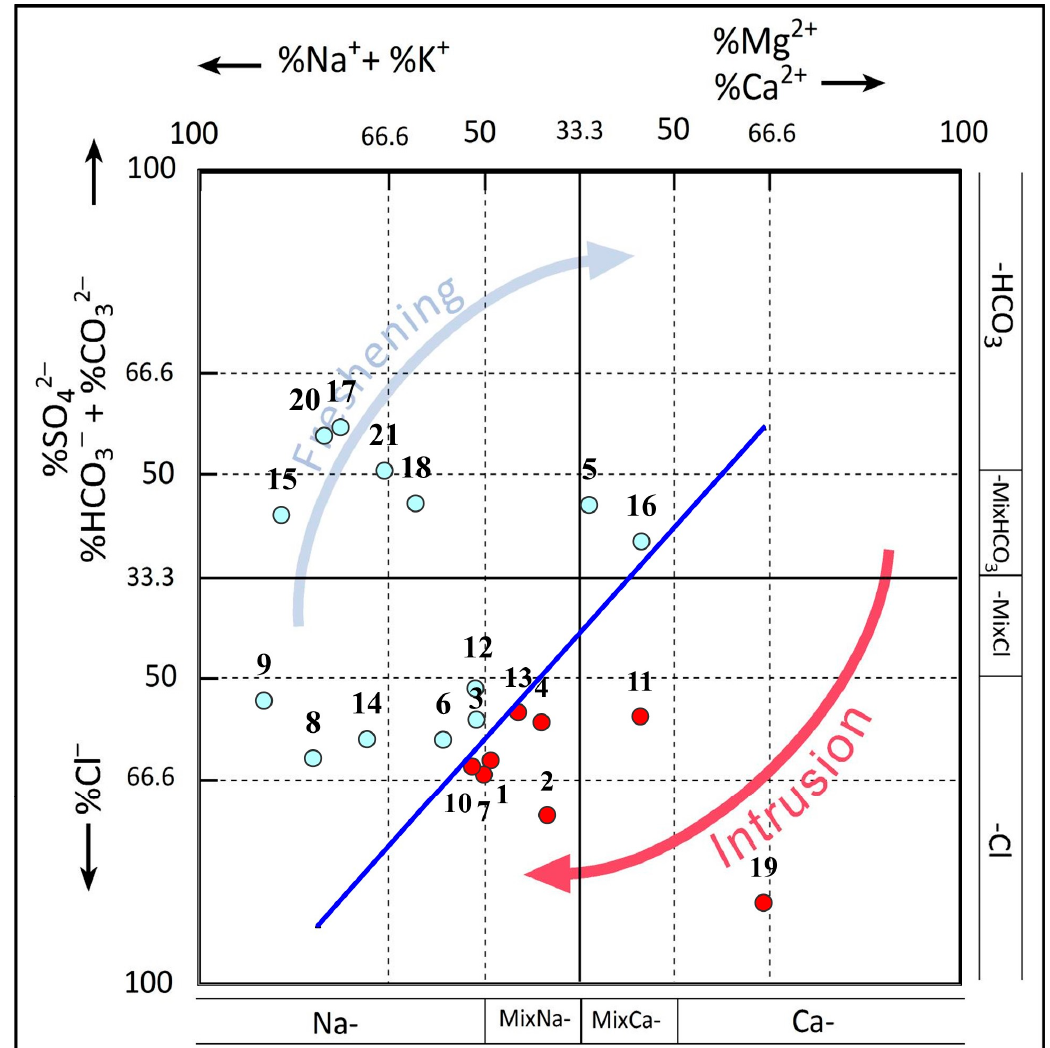
Figure 5. HFE-Diagram of the studied groundwater samples.